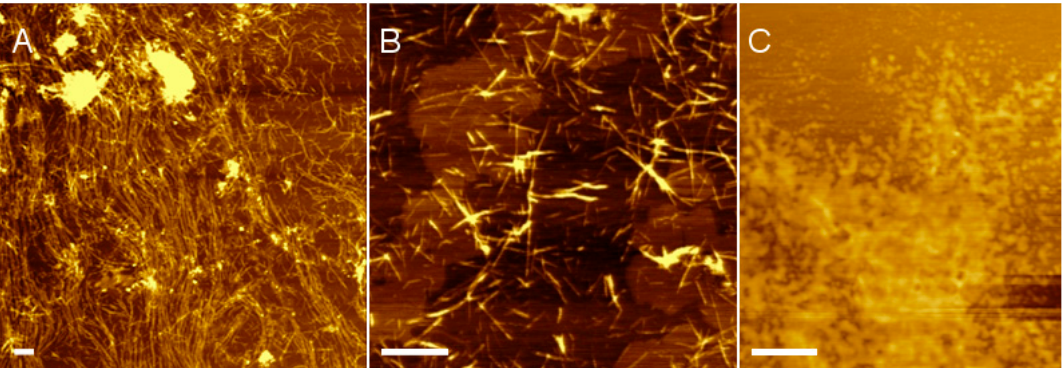
Figure 1. Atomic force microscopy (AFM) images of nanofiber morphology in ( A ) pristine (RADA) 4 , ( B ) a blend of 75%(RADA) 4 :25%(RADA) 4 K 5 (w/w), and ( C ) (RADA) 4 K 5 . Peptide solutions were prepared at 0.01% (w/v) in 10 mM phosphate buffer, pH 7.4. Scale bars 500 nm.